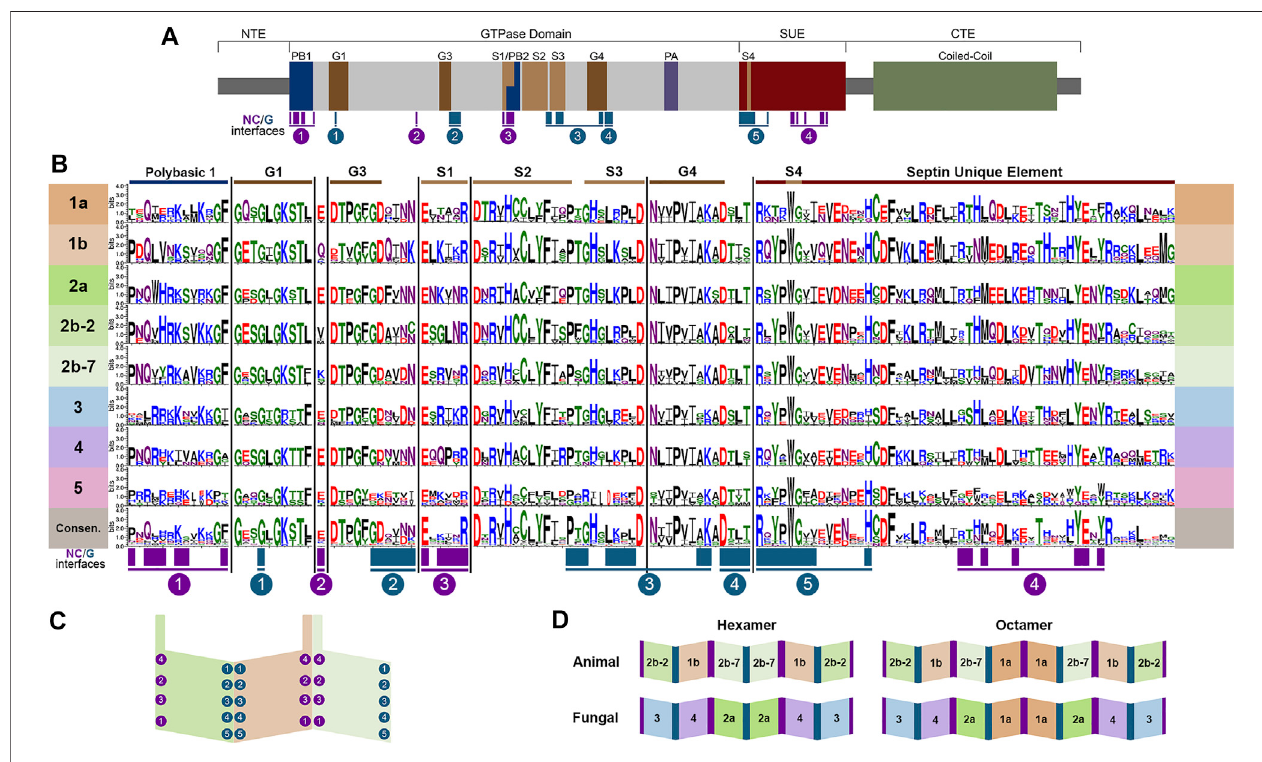
FIGURE 2 | Conserved septin domains and interfaces. (A) Septin conserved domains shown to scale modeled on human SEPT7. N-Terminal Extension (NTE), polybasic region (PB), GTPase domain motifs (G1, G3, G4), septin motifs (S1, S2, S3, S4), polyacidic region (PA), septin unique element (SUE), coiled-coil, and C-Terminal Extension (CTE). NC- and G-interface residues shown in magenta and teal. (B) Septins were aligned using Clustal Omega (Madeira et al., 2019) and WebLogo 3 (Crooks et al., 2004) was used to highlight conserved regions of septins listed in the table. (C) Representation of the SEPT2/6/7 trimer with interacting group designations adapted from Auxier et al. (Auxier et al., 2019). (D) Canonical hexamers and octamers from both animals and fungi highlighting positional orthologs.